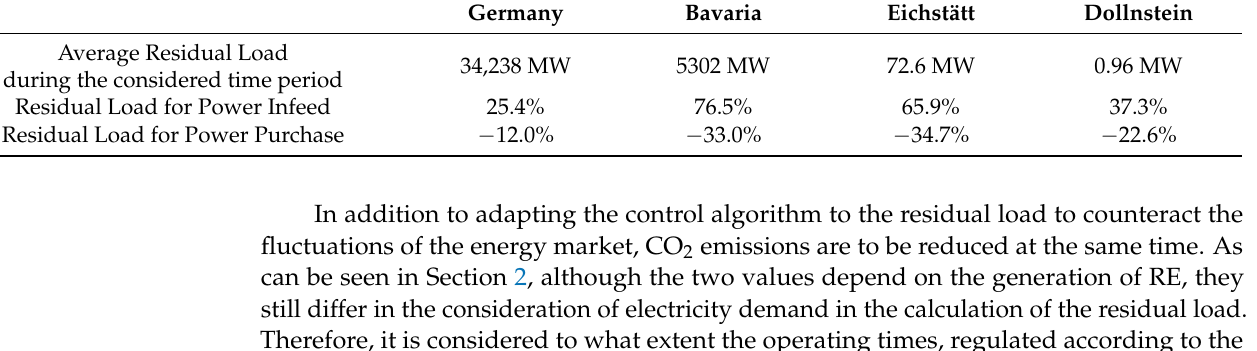
Table 3. Change in the average residual load at all levels of consideration ( Germany , Bavaria , Eichstätt , Dollnstein ) during power feed-in and power purchase compared to the reference system.